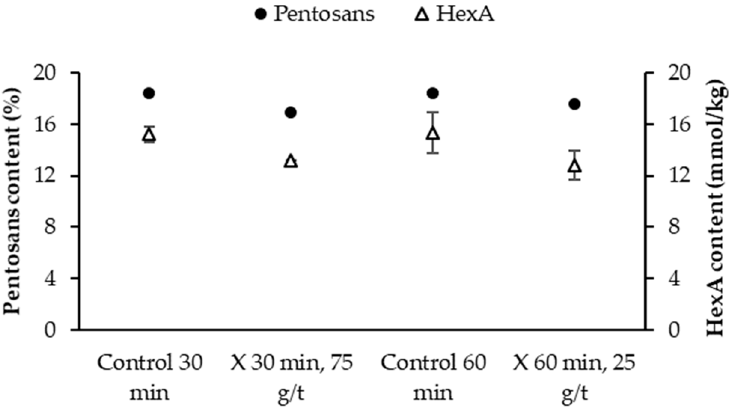
Figure 4. Effect of the bleaching sequences on pentosans and hexenuronic acid (HexA) contents. HexA content in the original pulp was 58.0 mmol/kg. The HexA content of enzyme- treated pulps was lower than that of untreated pulps as a result of their removal (Figure 4). As aforementioned, some of the xylan fragments that are released from the pulp by xylanase may contain HexA groups, thus explaining their lower amount in enzyme-treated